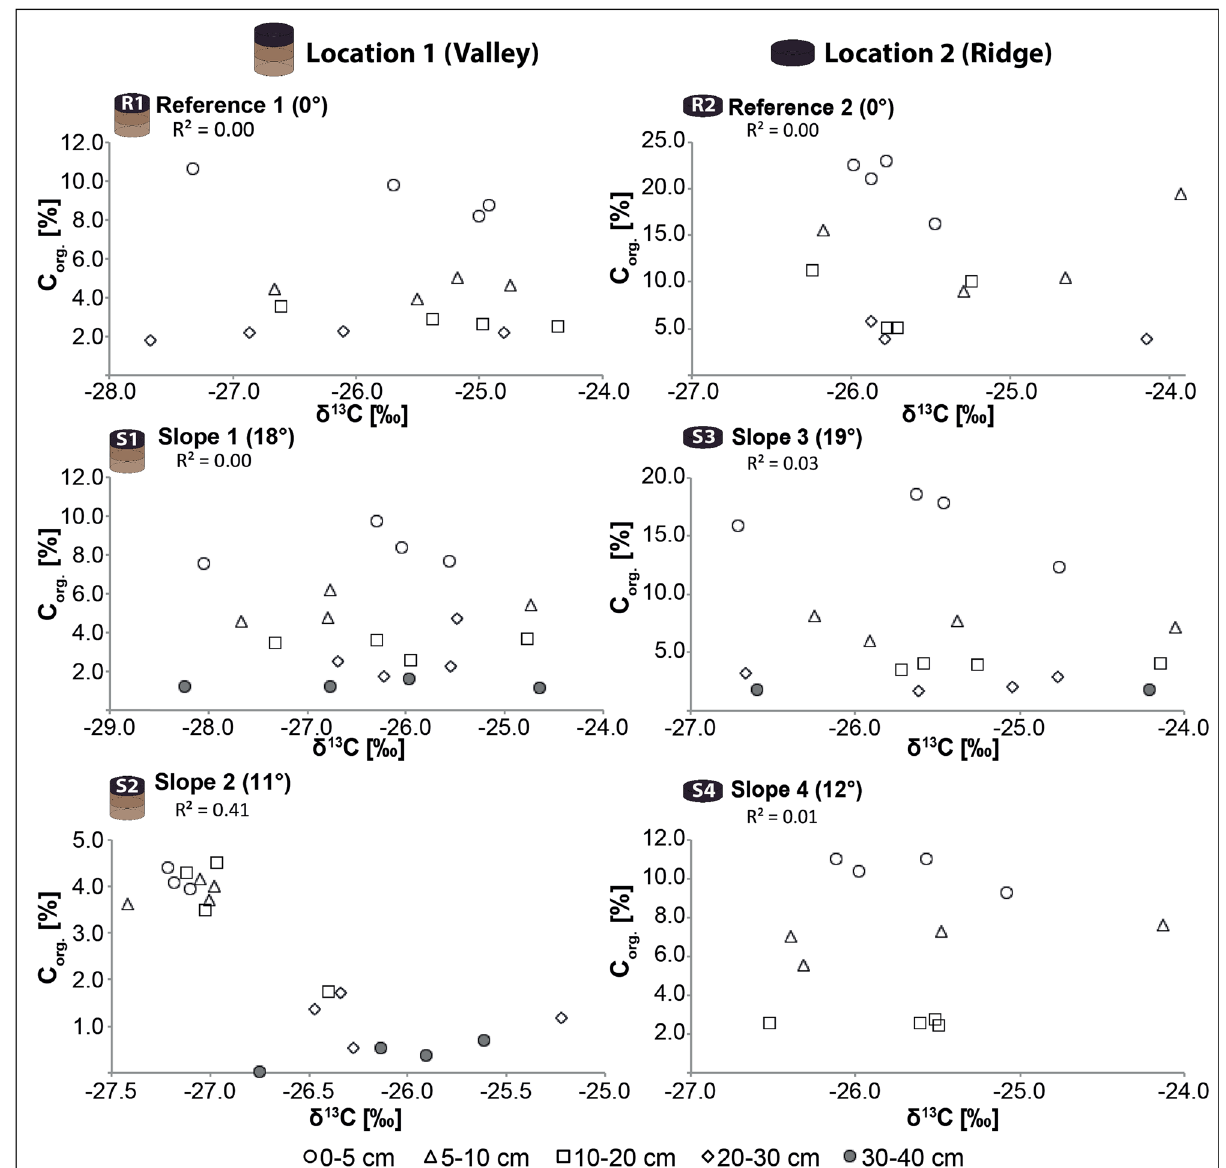
Figure 2. Correlation between C org (organic carbon content) and δ 13 C values as an indicator of soil disturbance/stability (the values are given in Table